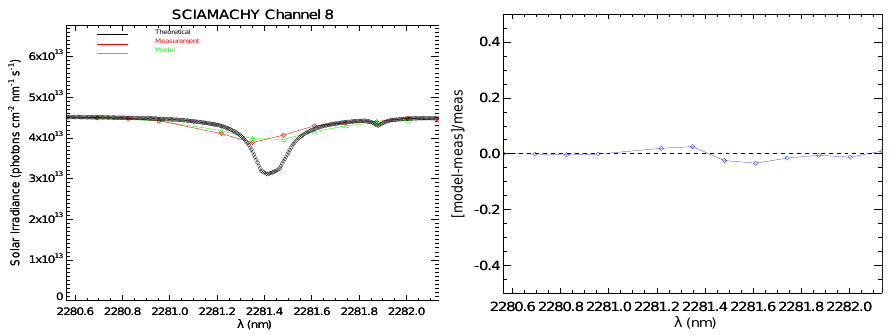
VersionFebruary20,2018submittedto RemoteSens. Figure 9. Similar to Figure 3 but for Channel 8 and Line 1. The corresponding retrieved ISRF is a Compound Hyperbolic function with a FWHM (cid:39) 0.31 nm. The residuals ( right ) rms (cid:39) 0.02.